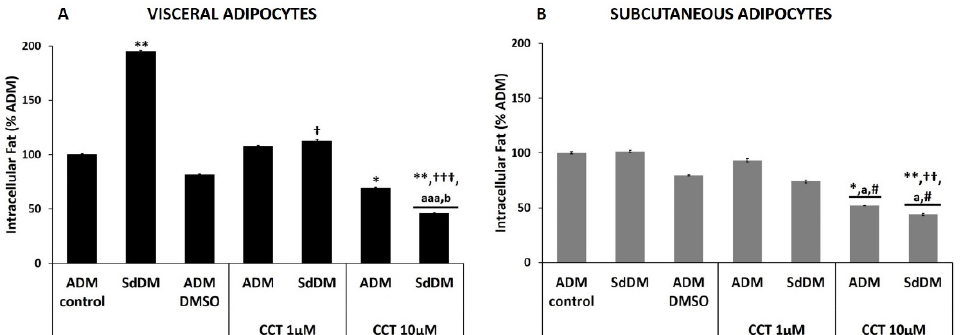
Figure 3. Effect of the SdDM secretome and CCT on the differentiation of healthy PA. The maximum intracellular fat detected for control differentiation (ADM-control) was set at 100%. Relative values of intracellular fat in different conditions are shown: SdDM-differentiated cells, ADM–DMSO, and CCT applied to ADM- and SdDM-differentiated cells. Values were obtained at 17 days post-induction. Panel ( A ): percentage of intracellular fat of visceral adipocytes. Panel ( B ): percentage of intracellular fat of subcutaneous adipocytes. Bars indicate mean ± SEM of absorbance ( λ 517 nm) from at least three replicates of each condition. Significant differences are represented as: *, ** compared to ADM-control p < 0.05 and p < 0.01, respectively. †, ††, ††† compared to SdDM p < 0.05, p < 0.01, and p < 0.001, respectively. # compared to ADM–DMSO, p < 0.05. “a, aaa” comparisons between CCT doses, p < 0.05 and p < 0.001. “b” comparison between SdDM–CCT and ADM–CCT (same dose), p < 0.05.